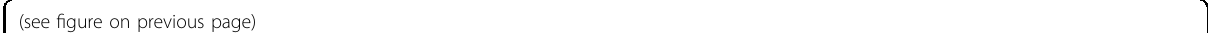
Fig. 5 Assessment of changes in myeloid cells in transcriptional pro fi les between MG patients and healthy controls. a UMAP plot displaying myeloid cells from two MG patients and two HCs separated into 9 subtypes. b Violin plots showing key gene markers across myeloid cells. c 3D diffusion map displaying the developmental trajectory of myeloid cells. The result shows the possible activation paths of macrophages/cDCs. Cells are colored by their derived clusters. pDCs, plasmacytoid dendritic cells; cDCs, conventional DCs. d Enrichment analysis of DEGs in dendritic cells between MG patients and HCs (selected among upregulated pathways in MG patients, P value < 0.05). e GSVA analysis of CD14 + monocytes between MG patients and HCs. f Dot plot of selected signi fi cant paracrine receptor-ligand interactions between CD14 + /CD16 + monocytes and cDCs discovered using Cellchat . Commun.Prob., communication